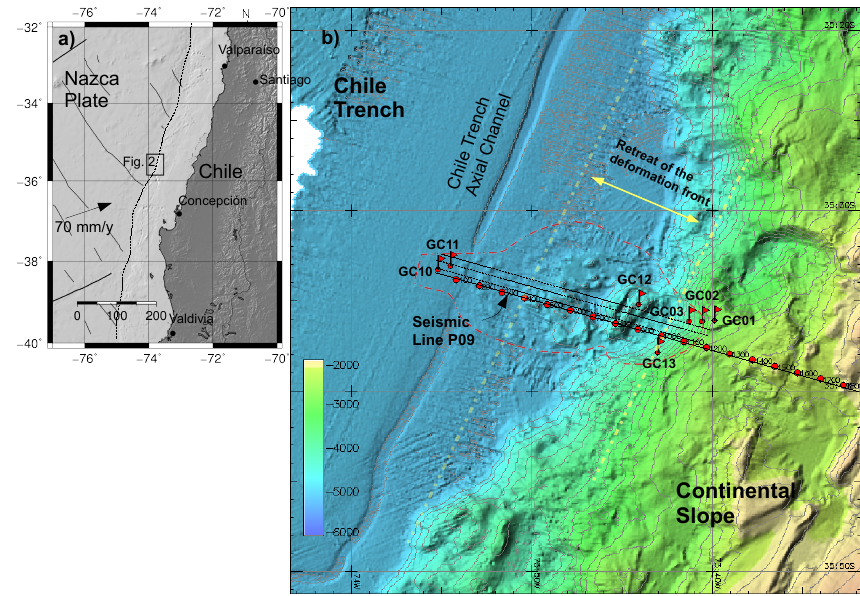
Fig. 1. Map view of Reloca Slide with positions of gravity cores (GC) and seismic line P09 of RRS JAMES COOK cruise JC23b. The red stippled line indicates the area affected by the slide, fine black stippled lines indicate positions of depth profiles used for Fig.